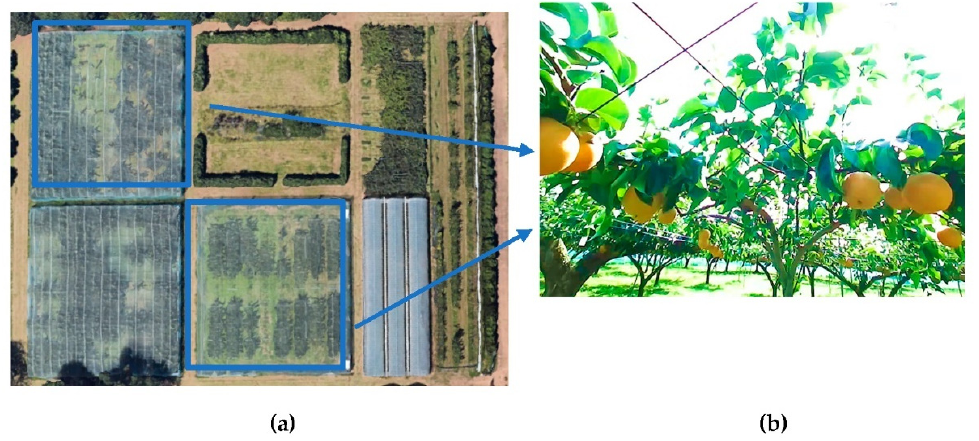
Figure 1. Aerial view of orchards for data collection located at the Tsukuba-Plant Innovation Re-